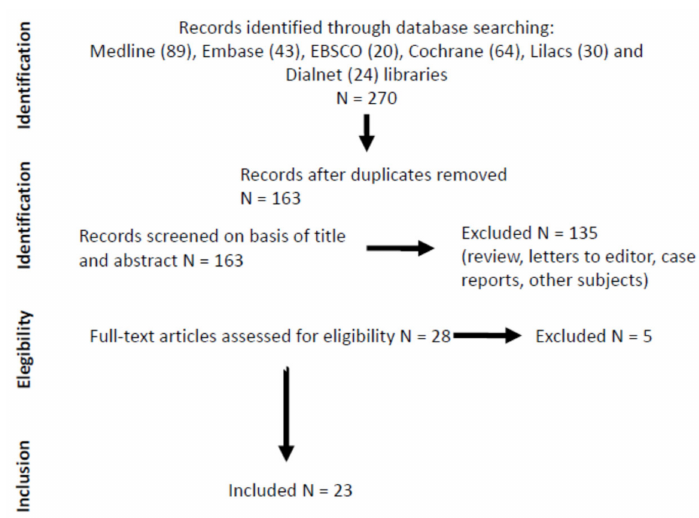
Figure 1. Preferred Reporting Items for Systematic reviews and meta-analyses (PRISMA) workflow for literature searches. Five of the studies [32–36] were not analysed in terms of the e ff ects of sarcopenia criteria, since they were intended to study some molecular or physiological e ff ects after short-term exposure to leucine (one to six